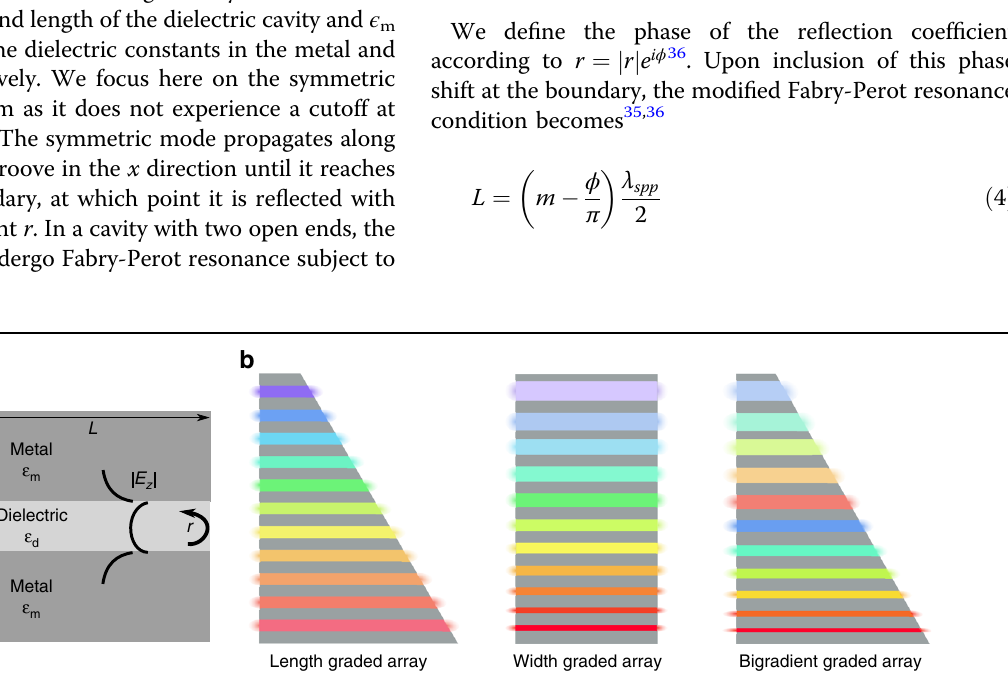
Fig. 1 Geometry of MIM groove and illustrations of the three array con fi gurations. a Schematic of an MIM groove structure. b Illustrations of rainbow trapping in width-graded, length-graded and bigradient groove arrays illustrating the changing resonant wavelength and fi eld intensity with respect to the groove